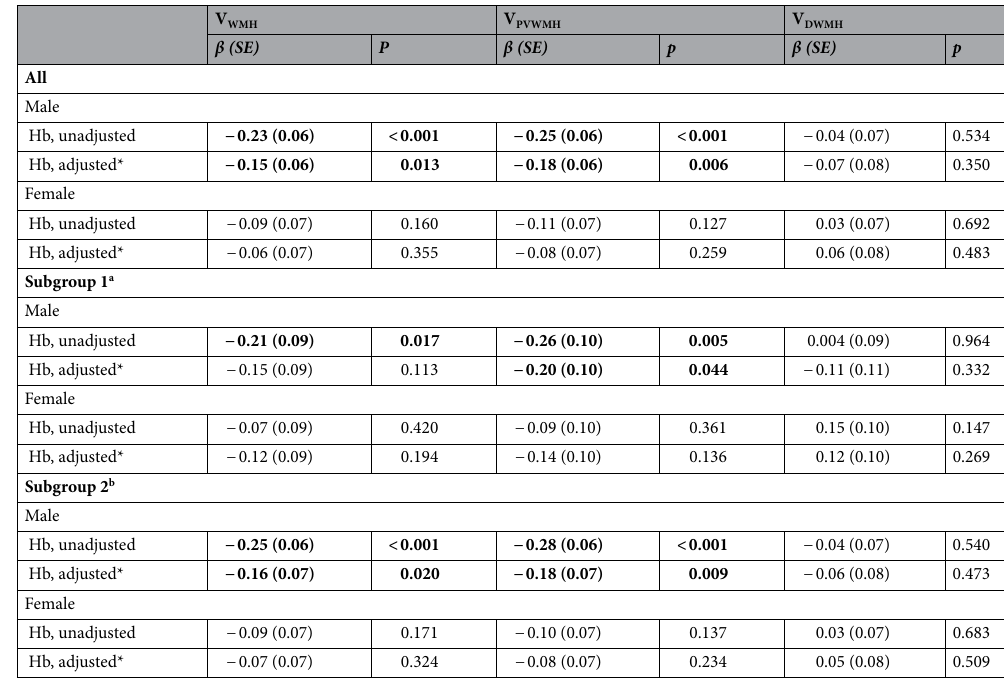
Table 2. Linear association between serum free hemoglobin level and white matter hyperintensity volume. Hb hemoglobin,